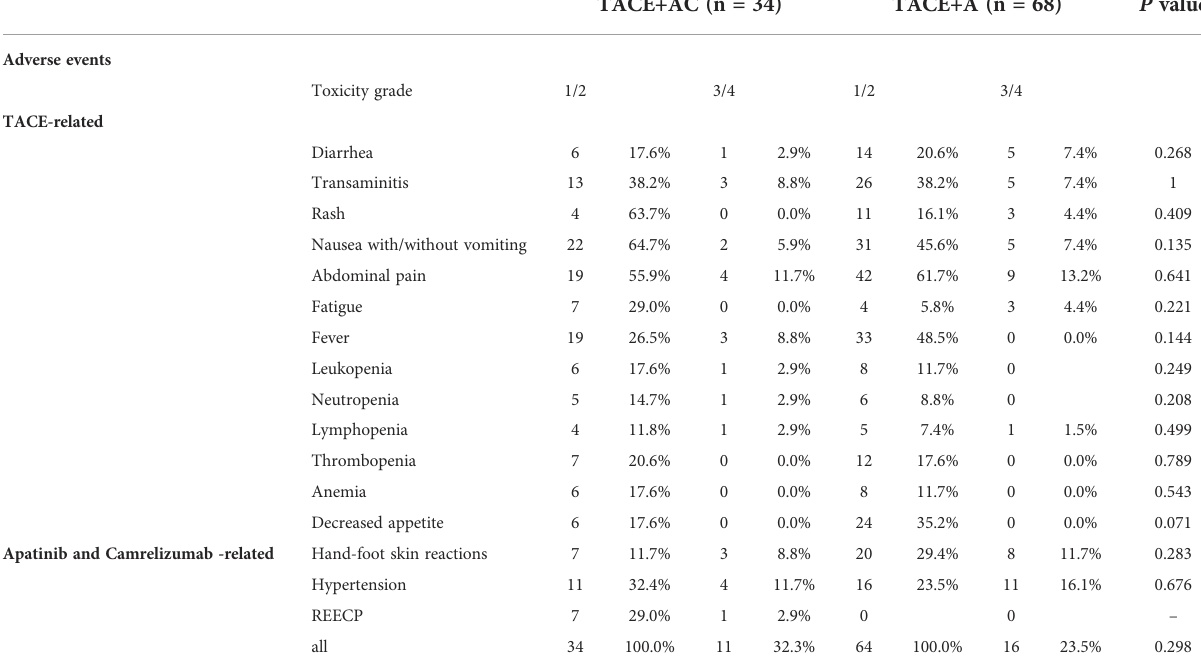
TABLE 3 Treatment-related adverse events in the two